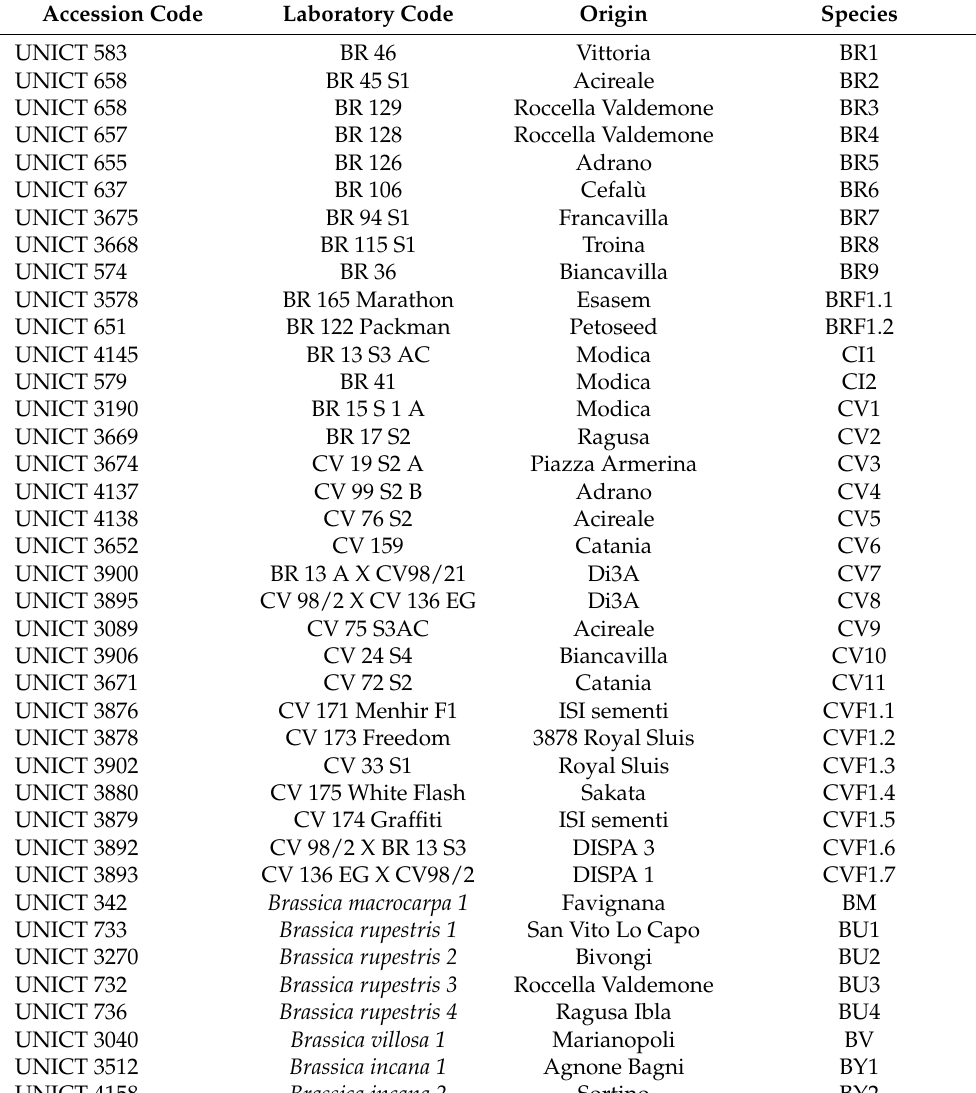
Table 6. List of B. oleracea complex species ( n = 9) utilized in the experiment, with cauliflowers and broccoli F1 and landraces, respectively, and crop wild